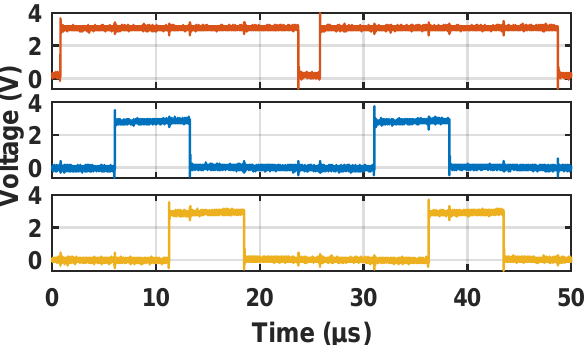
Figure 17. The PWM signal of the SVPWM algorithm with the OVDT of the 2-norm.